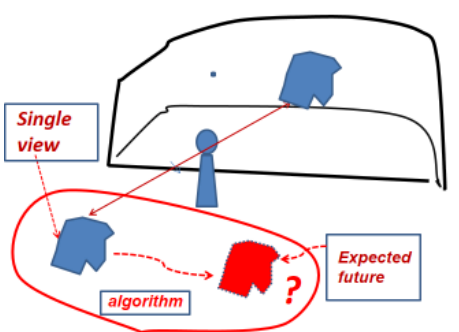
Figure 1. Plato said that we see the shadows of things, like a pris- oner constrained to view the end of a cave and forbidden to turn and see the outside world. This occurs indeed in perceptual tasks, where the sensorial stimuli are interpreted by “algorithms” and gen- erate (within1 sec) a motor reaction. The procedure is common to all brainy animals.